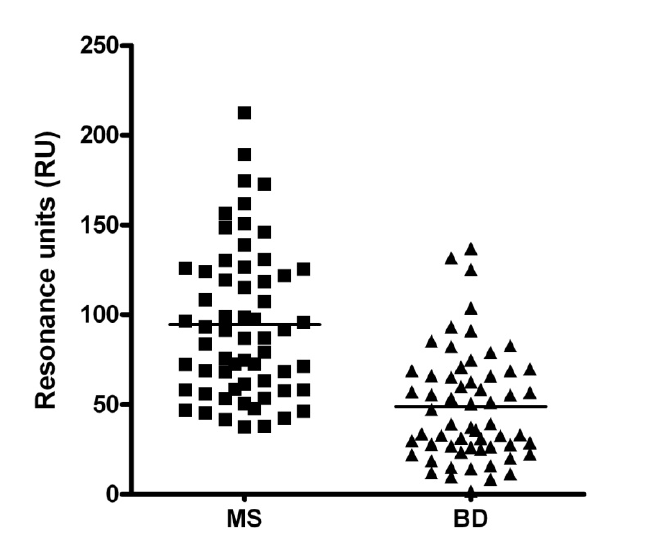
Figure 2. Column scatter and mean values of anti-CSF114(Glc) antibodies (dilution 1:50) in Multiple Sclerosis (MS, n = 61) and blood donors (BD, n = 60). The lines indicate the mean value of each